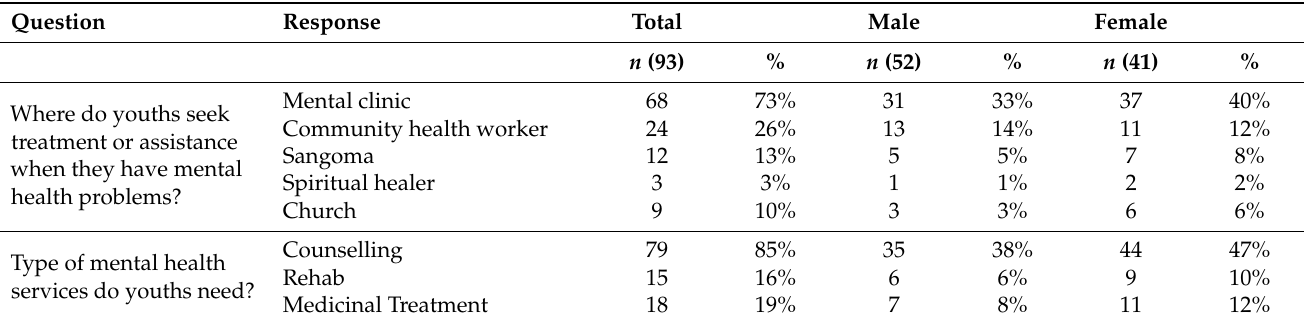
Table 4. Showing responses of participants to the question on availability and type of mental health